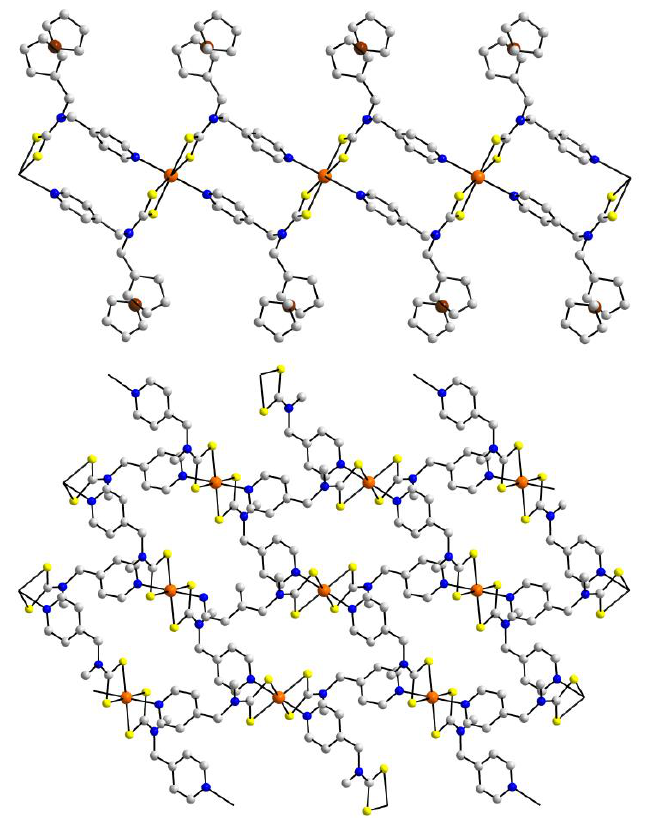
Figure 7. Two views of the two-dimensional array formed by [Zn(L 5 ) 2 ] 2 in the crystal of 25 . In the lower view, only the α-carbon atom of the ferrocenyl (Fc) substituent is shown.